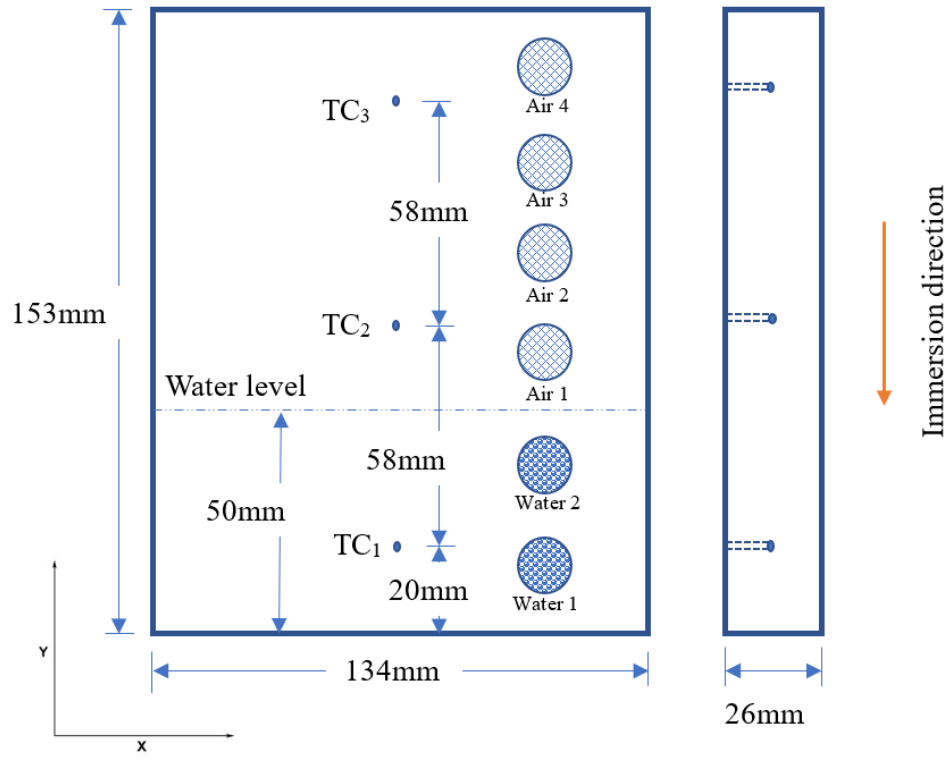
Figure 1. Schematic of the part dimensions, locations of thermocouples, water level, locations of corrosion measurement sites, and the immersion direction .